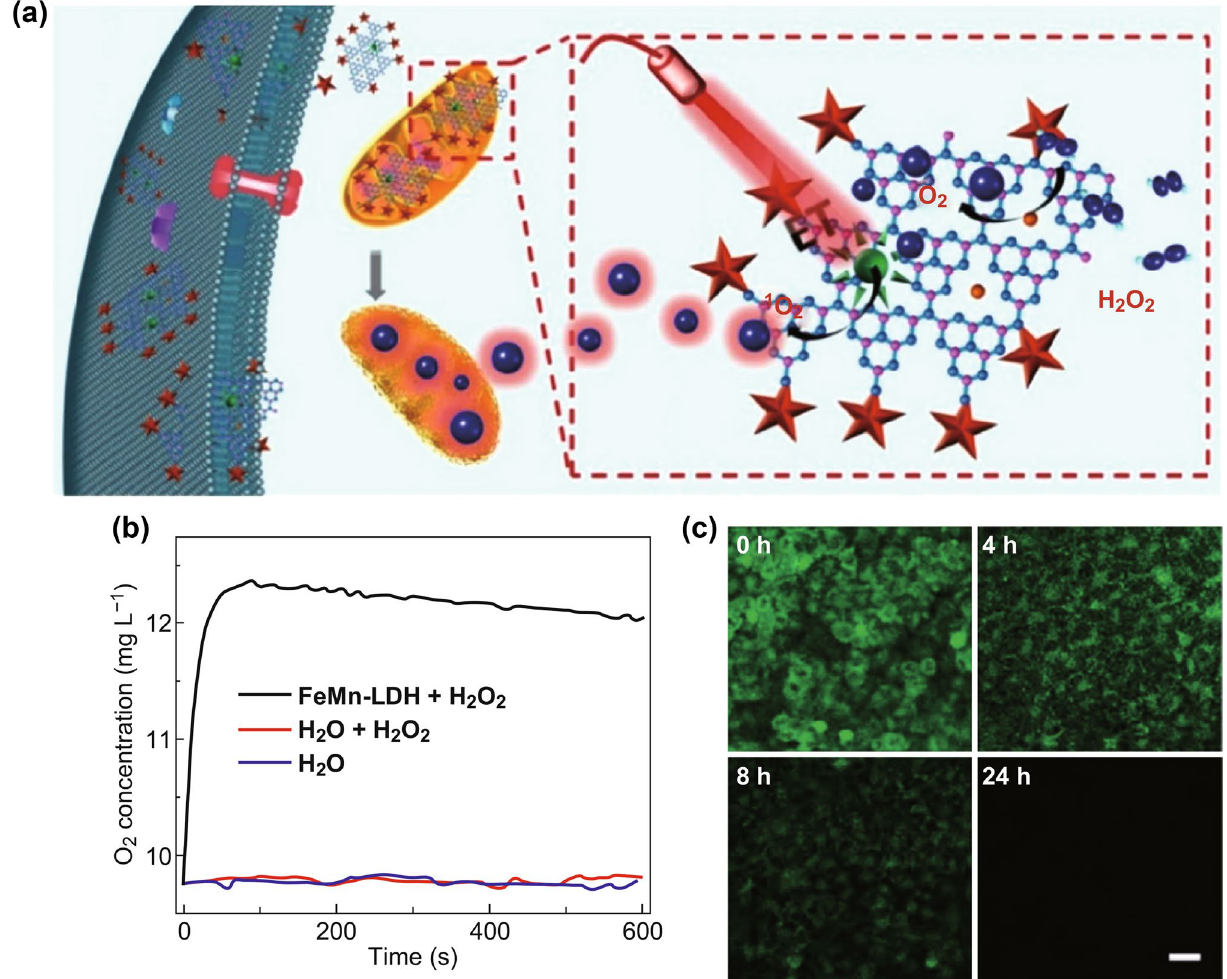
Fig. 6 a Schematic illustration of C 3 N 4 -Fe-TPP NF/MB as theranostic nanocomposites for mitochondria-targeting H 2 O 2 -enhanced PDT. Adapted with permission from Ref. [37]. Copyright 2016 Wiley–VCH. b O 2 was catalyzed by FeMn-LDH adding H 2 O 2 (100 mM). c Evolution of O 2 in HeLa cells incubated with O 2 probe RDPP and FeMn-LDH (100 mg mL −1 ) at different time (0, 4, 8, and 24 h). Adapted with permis- sion from Ref. [38]. Copyright 2018 Royal Society of